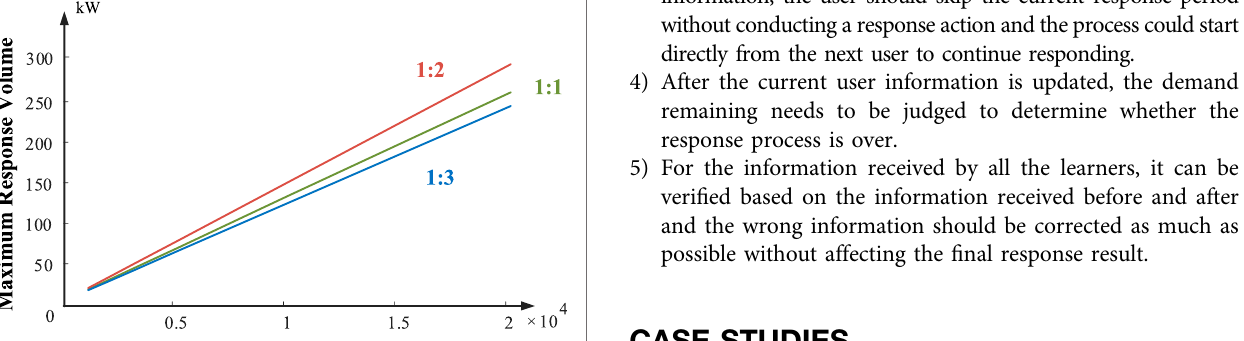
TABLE 2 | Maximum response volume of different numbers of users with different type ratios and different information error rates. Number of users Ratio of fi xed-frequency